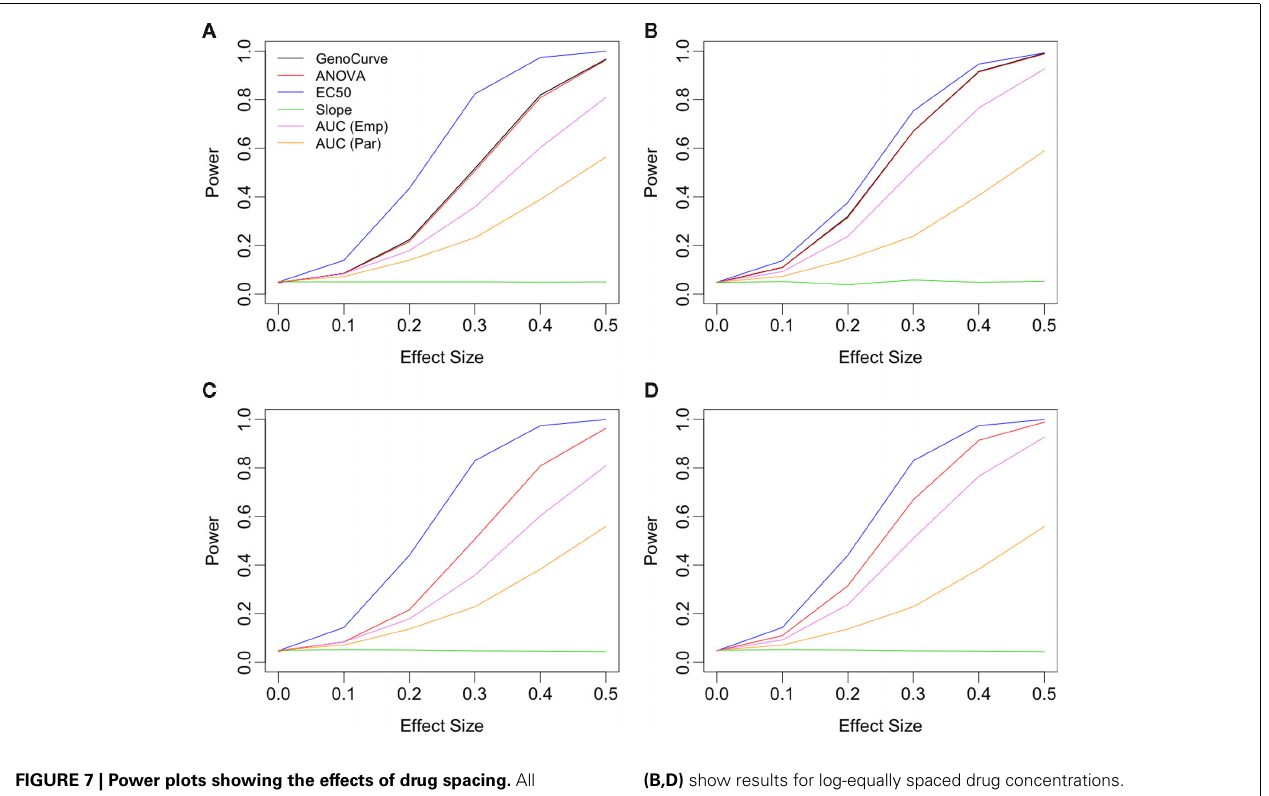
FIGURE 7 | Power plots showing the effects of drug spacing. All plots consider an alternative with IC50 as the affected parameter, with a dominant genetic model and a MAF of 0.25. Plots (A,C) show results for equally spaced drug concentrations, while plots